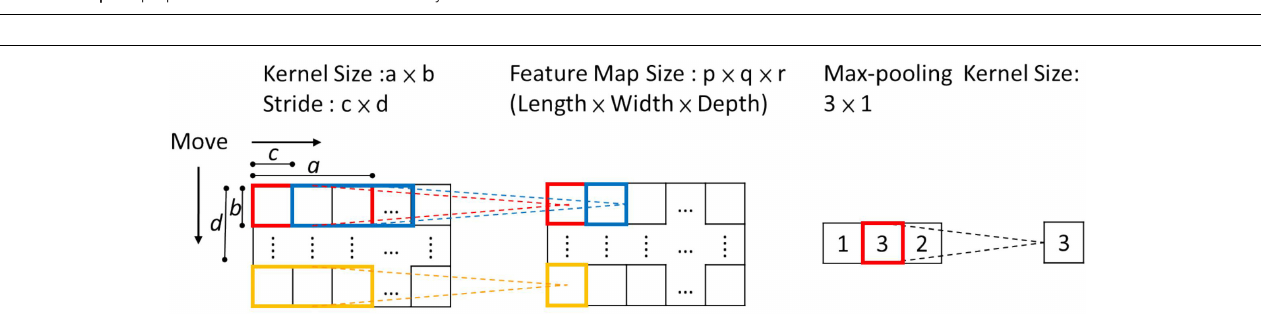
FIGURE 1 | The proposed CNN architecture in this study.